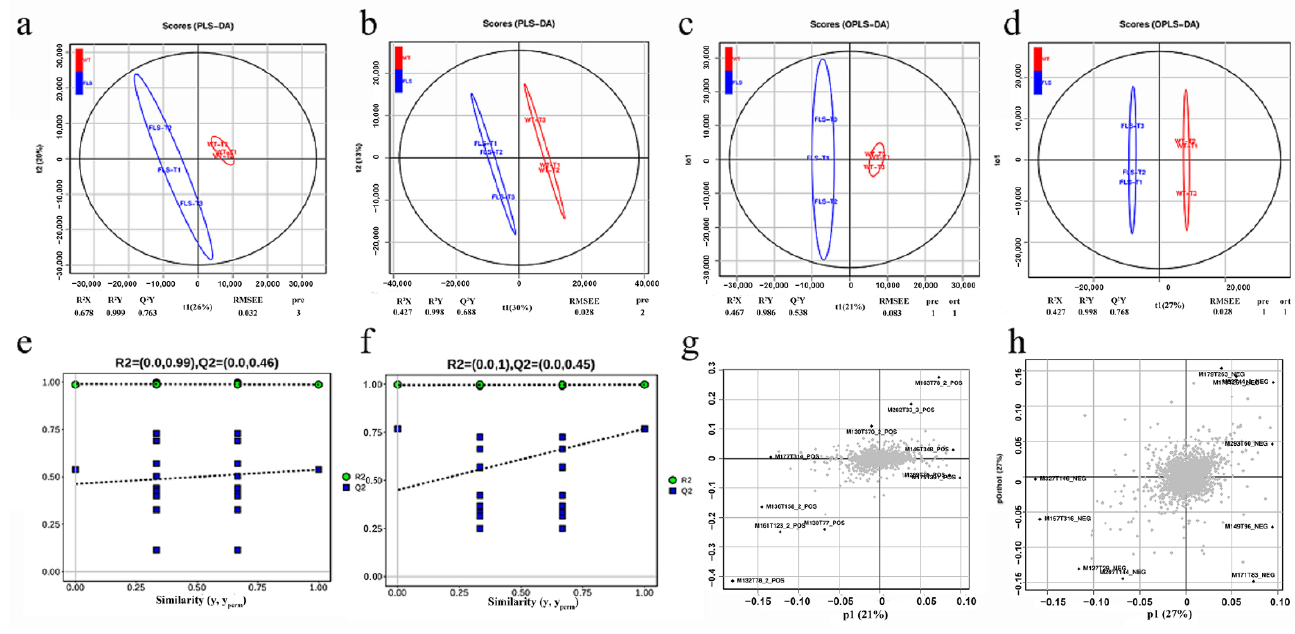
Figure 7. PLS-DA and OPLS-DA of WT and RuFLS2-OX tobacco. PLS-DA analysis of WT and RuFLS2-OX tobacco with positive ( a ) and negative ( b ) patterns. OPLS-DA of WT and RuFLS2-OX tobacco with positive ( c ) and negative ( d ) patterns. The OPLS-DA displacement test of WT and RuFLS2-OX tobacco with positive ( e ) and negative ( f ) patterns. Loading plot diagram of WT and RuFLS2-OX tobacco with positive ( g ) and negative ( h ) patterns.